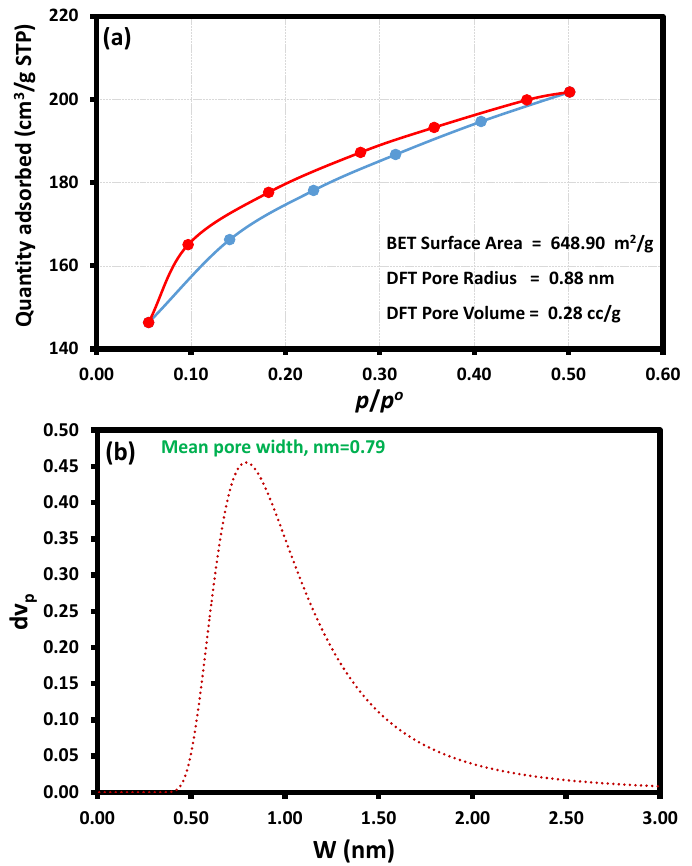
Figure 2. ( a ) Adsorption/desorption isotherm and ( b ) pore size distribution of activated carbon from palm tree fiber (PTFAC).